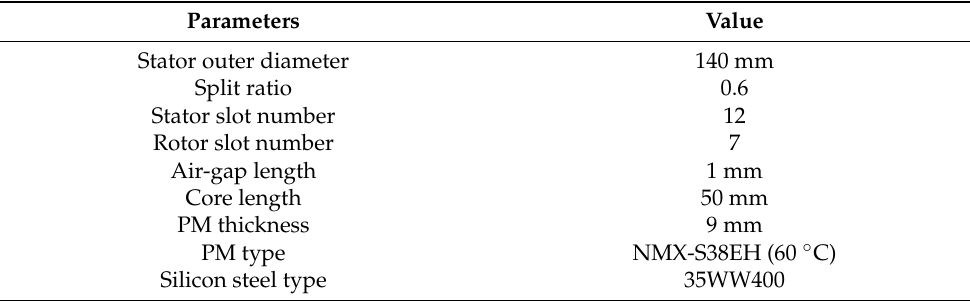
Figure 2. Magnetic field profile distribution of the proposed machine. Table 1. Design Parameters of the Proposed